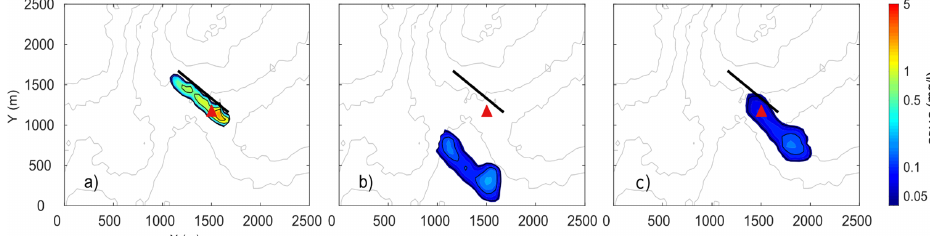
Figure 10. The lateral extension and SPMC of 2 µm class particles in the simulated plume at 0–1 mab (first vertical grid cell). The plume is dispersed and advected by the prevailing current (see Figure 9). Results are shown 10 min ( a ), 6 h ( b ), and 11 h ( c ) after the end of EBS towing. Black line represents the 740 m long EBS (seafloor erosion) track. Red triangle is the BoBo lander location. The colourbar starts from 0.05 mg/L (near background SPMC).